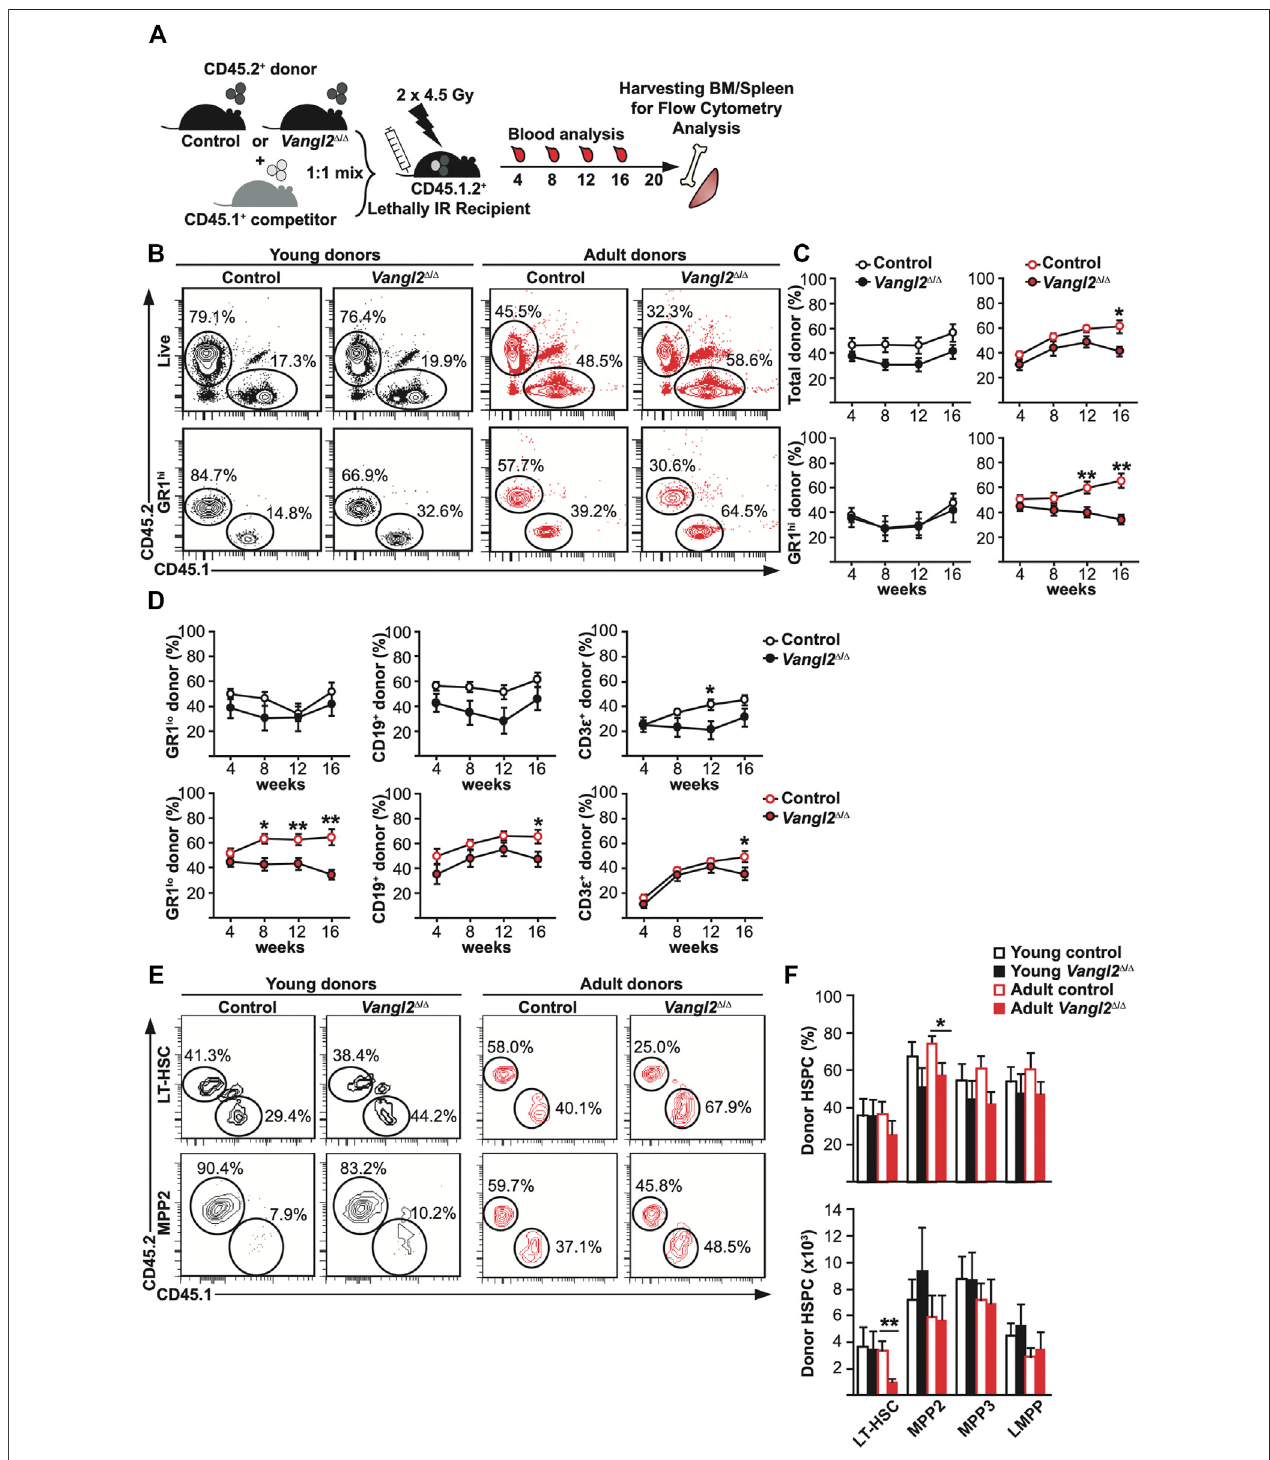
FIGURE 4 | Vangl2 is required for hematopoietic reconstitution in adult donors. (A) Experimental design for primary transplants (B) Representative fl ow cytometry datashowingthepercentageofdonor-derivedtotalandGR1 hi cellsinrecipientperipheralbloodpost-transplantforyoung(2-month-old)andadult(6-month-old)donors at 16 or 12 weeks post-transplant, respectively. (C) Graphs represent pooled results of donor-derived total and GR1 hi cells in recipient peripheral blood for young and adult donors (mean +SEM). (D) Graphs represent pooled results of donor-derived GR1 lo cells, CD19 + B cells and CD3 ε + T cells in recipient peripheral blood for youngandadultdonors(mean+SEM). (E) Representative fl owcytometrydatashowingthepercentageofCD45.2 + donor-derivedorCD45.1 + competitorLT-HSCs(top